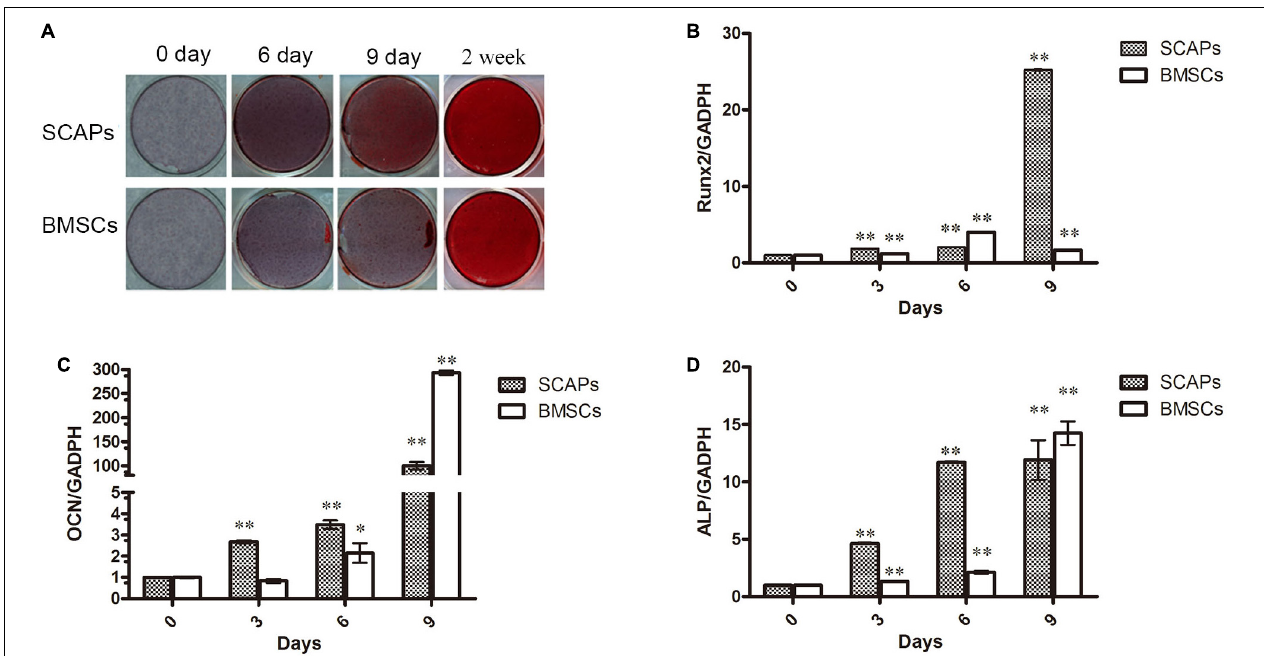
FIGURE 1 | Stem cells from dental apical papilla (SCAPs) and bone marrow–derived stem cell (BMSCs) exhibit odontogenic/osteogenic differentiation. (A) Photographs of alizarin red–stained mineral deposits in the cultures of SCAPs and BMSCs after 6, 9, and 14 days in mineral-inducing medium. Mineral accumulation was observed from day 6 after induction. (B–D) Expression of odontogenesis/osteogenesis marker genes. The expression of osteocalcin (OCN), runt-related transcription factor 2 (RUNX2), and alkaline phosphatase (ALP) were increased after induction. PCR expression level is the fold change relative to the levels on day 0; all data are presented as the mean ± SD; ∗ p < 0.05, ∗∗ p < 0.01 versus day 0; each experiment was repeated three